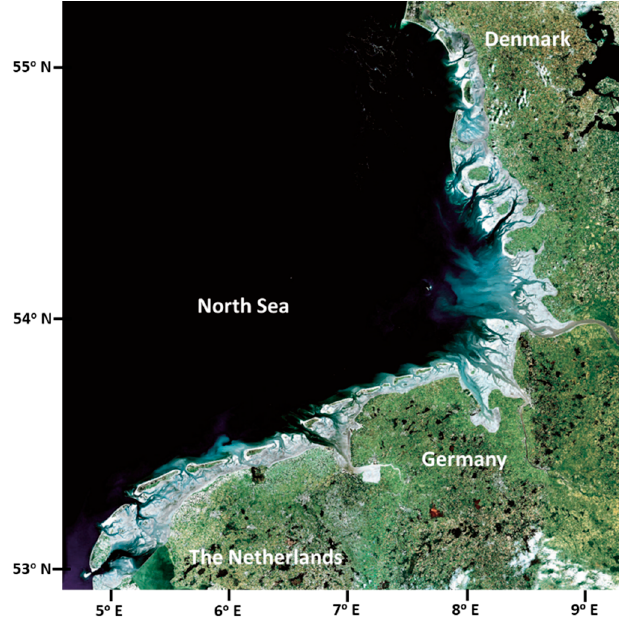
Figure 1. Wadden Sea, the light-colored areas between the barrier islands and the mainland coast (based on picture from www.waddensea-secretariat.org).